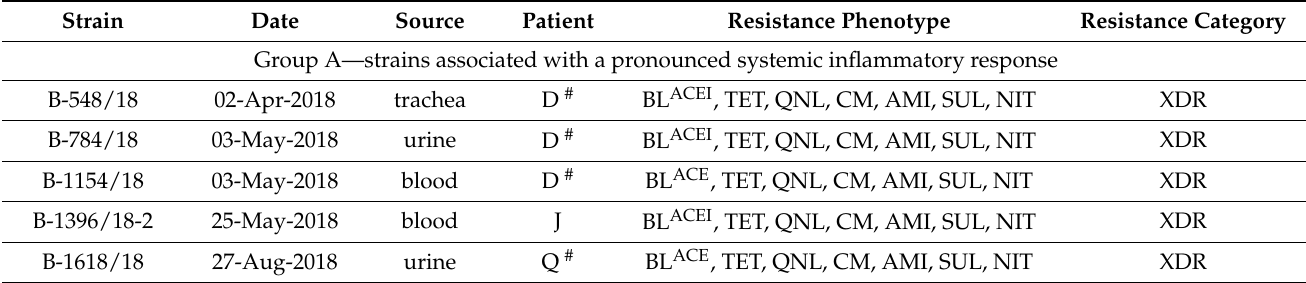
Table 2. Sources of isolation and antimicrobial resistance phenotypes of K. pneumoniae strains.